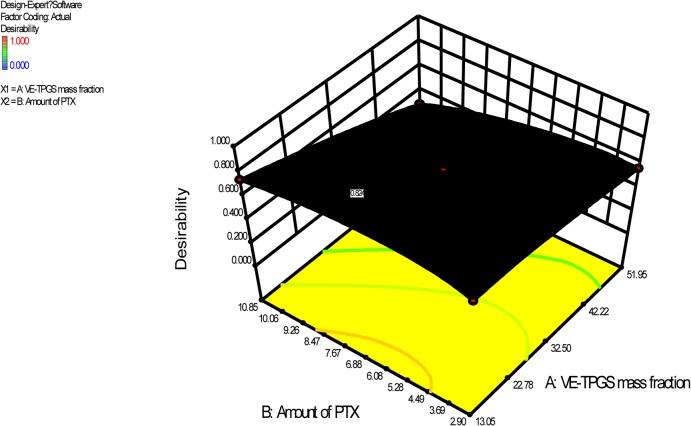
Response 3D surface in terms of desirability as suggested by the simulation for the optimization work.